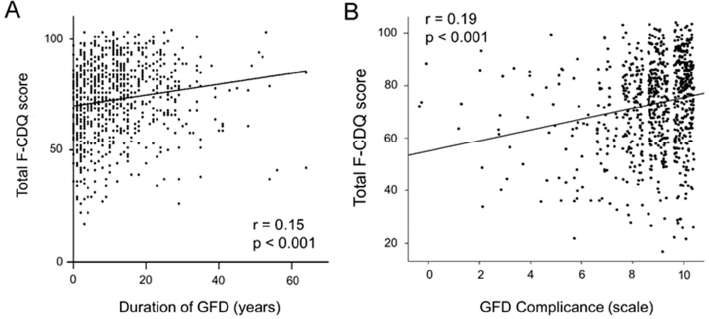
Figure 2. Correlation between total F-CDQ and GFD duration ( A ) and correlation between total F-CDQ and GFD compliance over the past 6 months ( B ) . Table 3. Total F-CDQ score according to patients and disease characteristics.